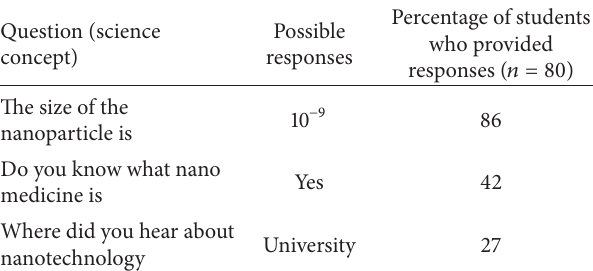
Table 1: Students’ responses in the nano section.